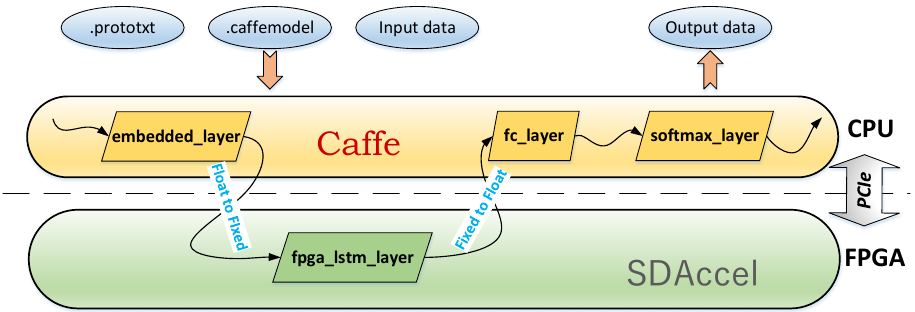
Figure 8. Integration with Caffe.